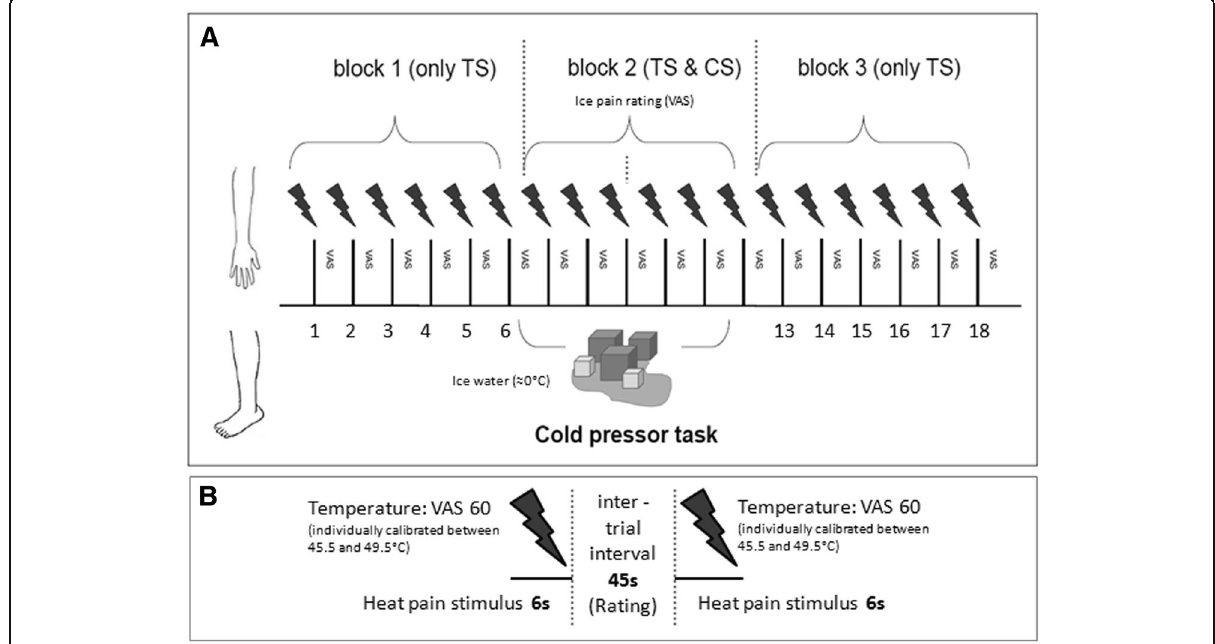
Fig. 1 Experimental sequences of the CPM paradigm used in this study. ( a whole experiment, b temporal components of trials). During block 1 and 3, the test stimulus (TS) was applied alone, whereas during block 2, the TS and a conditioning stimulus (= cold pressor task using ice water; CS) were applied concurrently. Subjects had to rate the pain intensity of TS and CS on a visual analogue scale